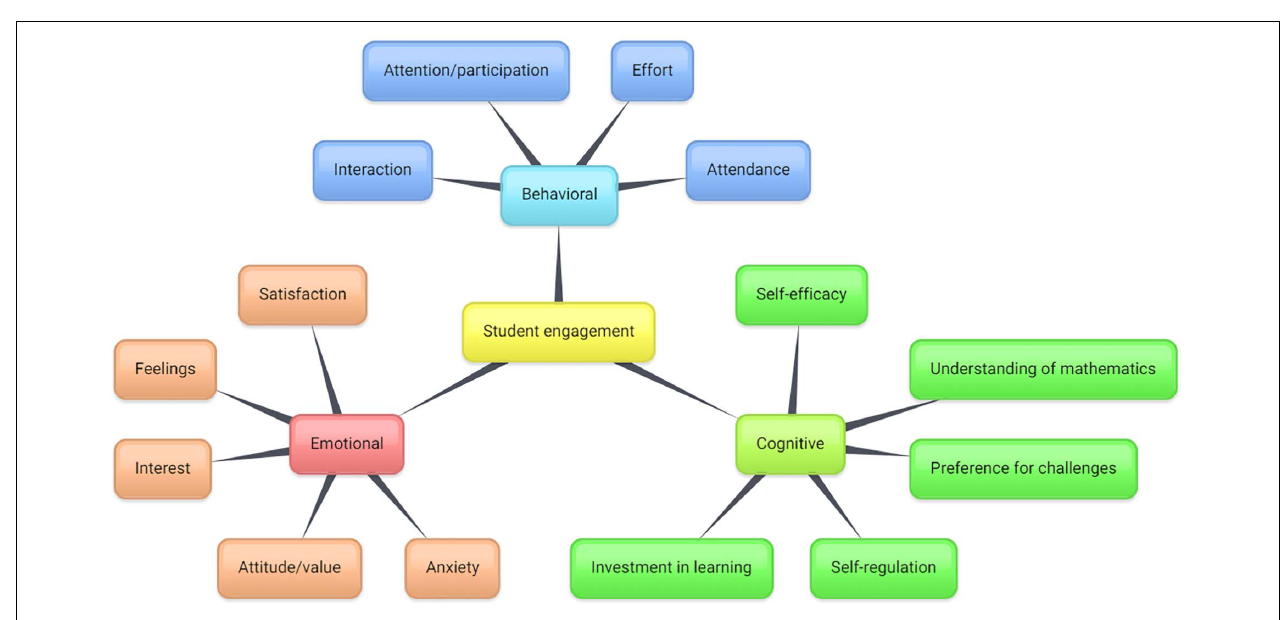
FIGURE 3 | The results of the thematic analysis of the comparison